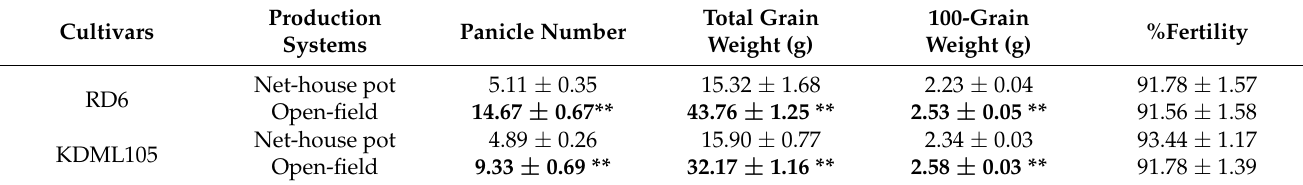
Table 2. Productivity of the two elite Thai rice cultivars grown in the net-house pot and open-field production systems. Cultivars